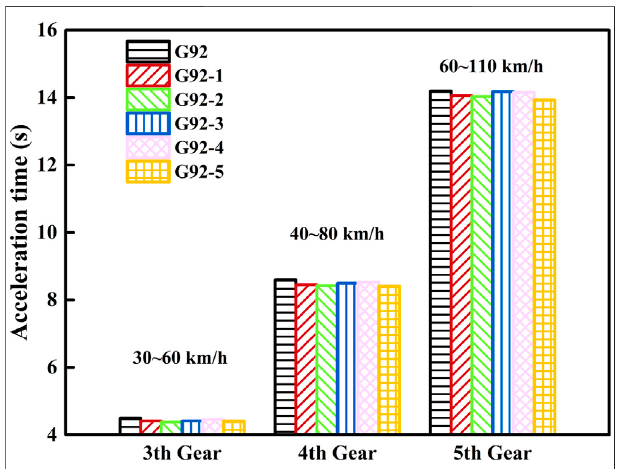
FIGURE 3 | Effects of different additives on acceleration time of the